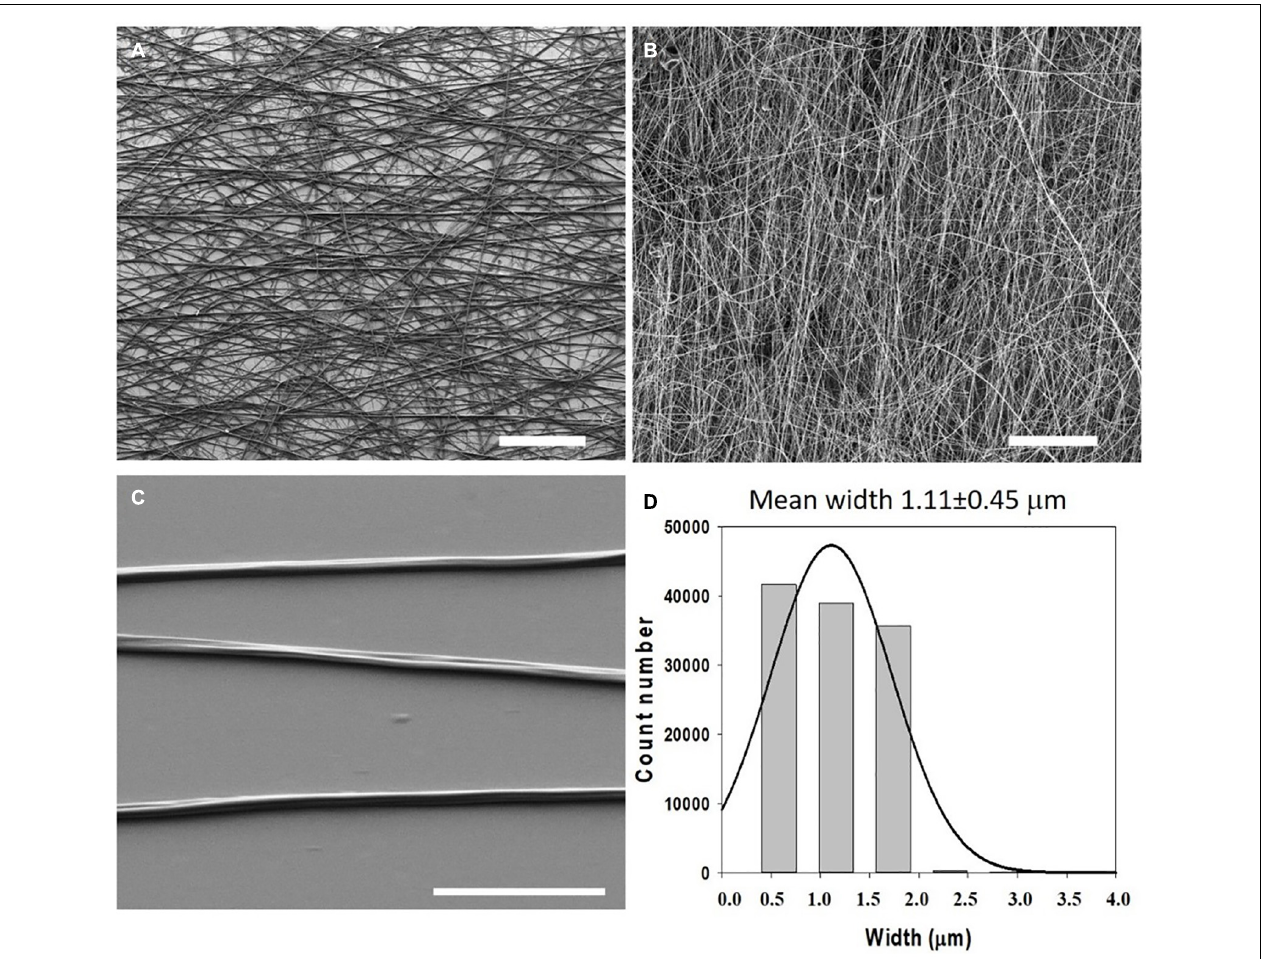
FIGURE 4 | Morphology and dimensions of the first ELR-click fibers. SEM micrographs of ELR-click fibers at different magnifications. Scale bars: (A,B) 100 mm, (C) 10 mm. (D) Statistical distribution of the fiber widths was obtained using the DiameterJ plug-in of Fiji (ImageJ). Fitting to a Gaussian distribution (continuous line) gave a mean width of 1.11 ± 0.45 mm. Reproduced with permission from: (doi.org/10.1016/j.actbio.2018.03.027), copyright